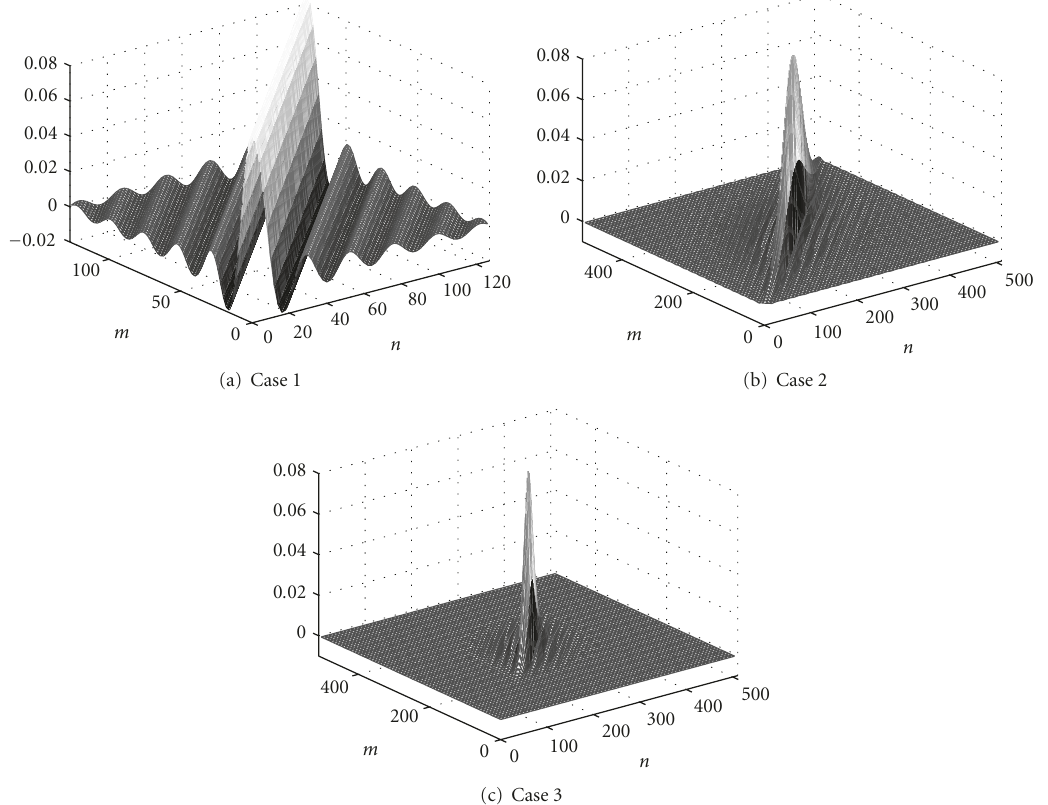
Figure 1: The three di ff erent test covariance matrices for bandlimited white noise processes: (a) stationary process, (b) long-event nonstationary process, and (c) short-event nonstationary